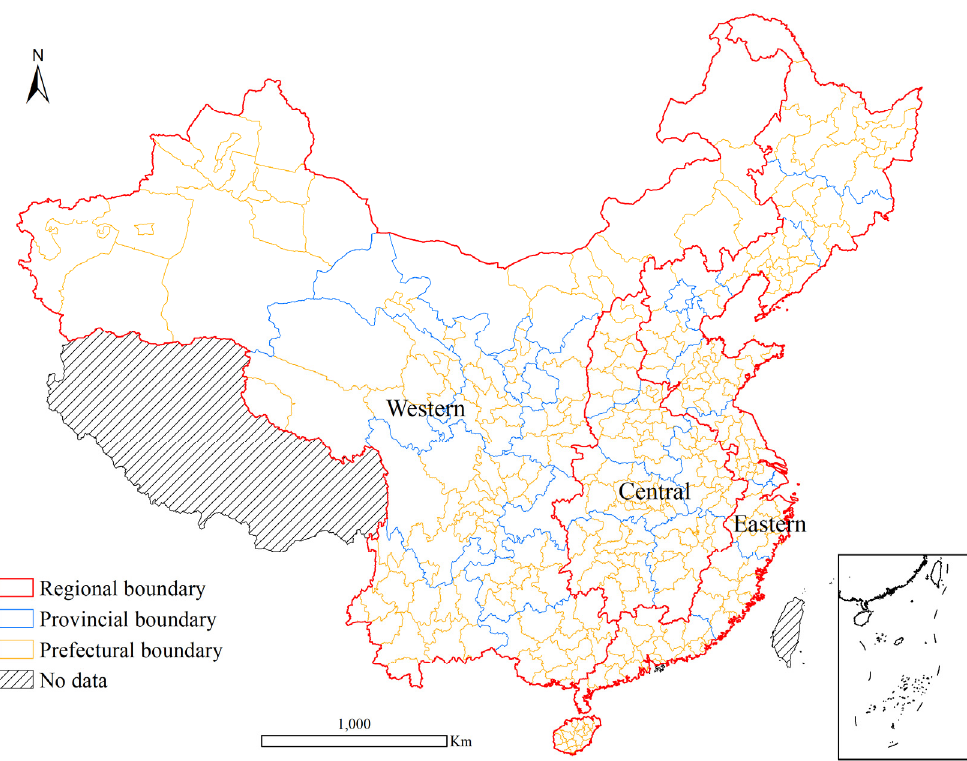
Figure 1. Spatial distribution of the study area.